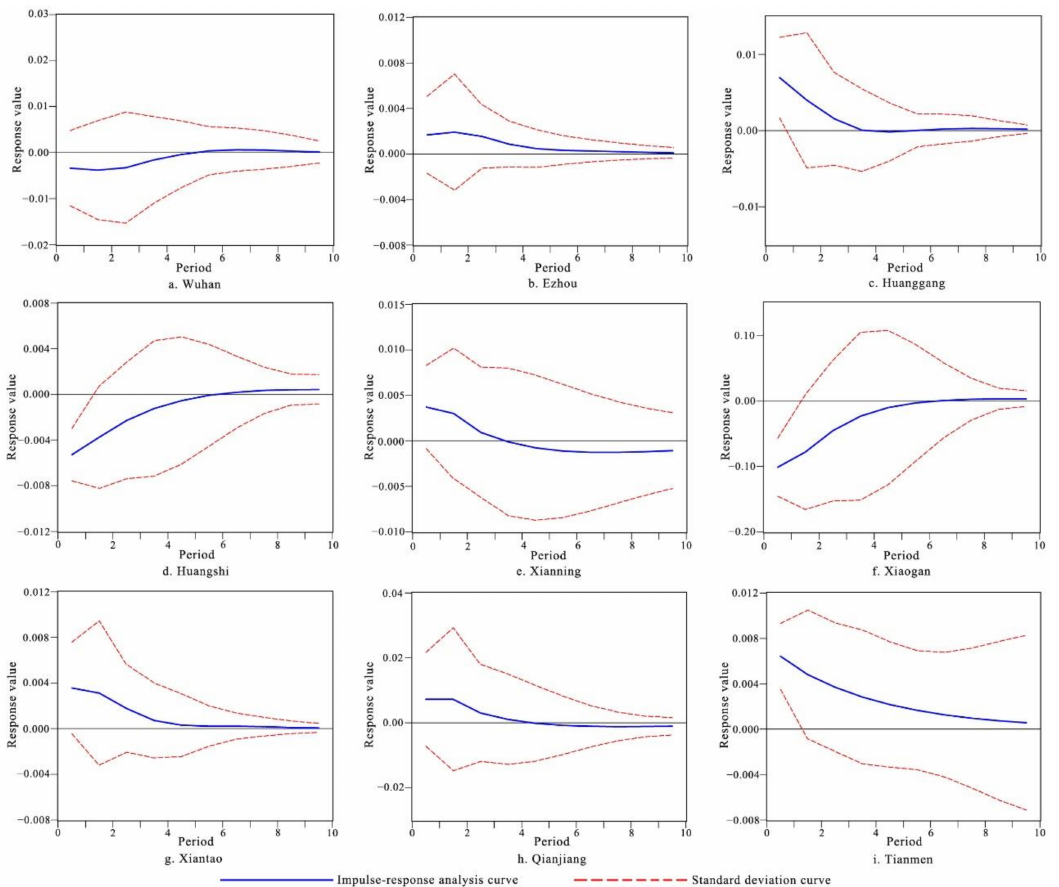
Figure 8. Response of ecological security to urbanization in Wuhan City